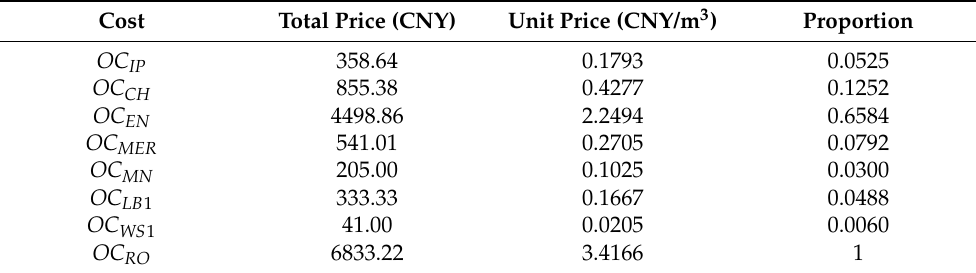
Table 17. SWRO system cost ratio